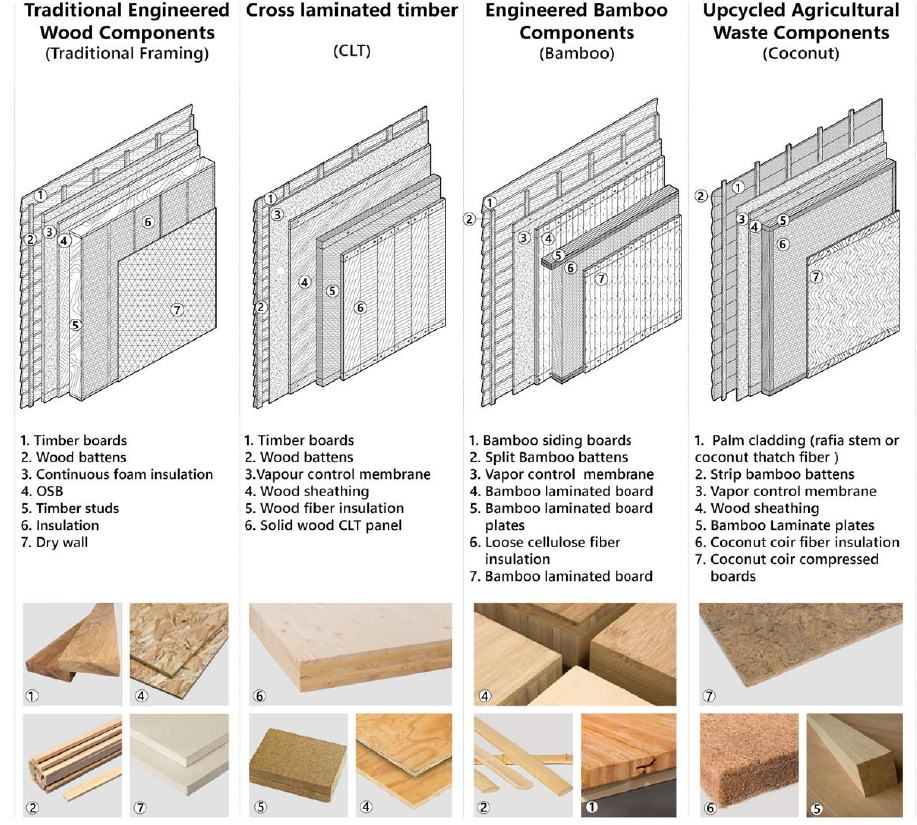
Figure 2. Wall assembly types for traditional framing, CLT, bamboo, and coconut, showing the con- struction assemblies designed to respond to the local climatic conditions in which they are found. Bills of materials for the four wall assemblies are reported in Tables 1 – 4, with indica- tion of those materials which may be reused at end of life. More detailed and complete bills of materials is provided in the Supplementary Materials. Table 1. Bill of materials for one functional unit (FU = 1 m 2 ) of traditional timber framing wall as- sembly. Reference flow = amount of material required per FU.